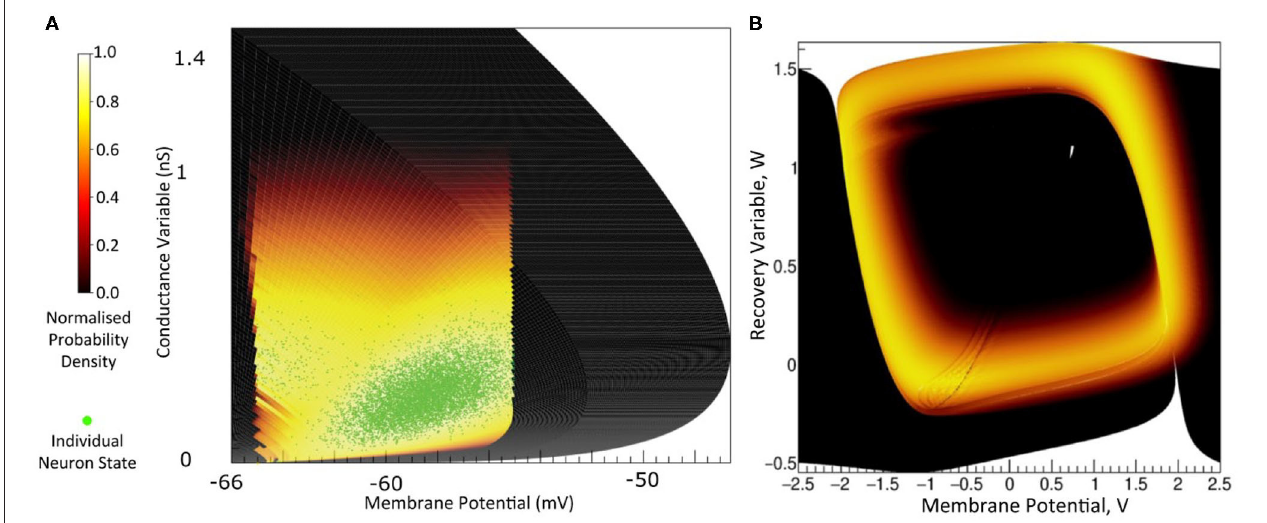
FIGURE 1 | (A) The state space of a conductance based point model neuron. It is spanned by two variables: the membrane potential and a variable representing how open the channel is. This channel has an equilibrium potential that is positive. The green dots represent the state of individual neurons in a population. They are the result of the direct simulation of a group of neurons. MIIND, however, produces the heat plot representing a density (normalised to the maximum density value) which predicts where neurons in the population are likely to be: most likely in the white areas, least likely in the red areas and not at all in the black areas. The sharp vertical cut of the coloured area at − 55 mV represents the threshold at which neurons are removed from state space. They are subsequently inserted at the reset potential, at their original conductance state value. (B) The state space of a Fitzhugh-Nagumo neuron model. The axes have arbitrary units for variables V and W . There is no threshold-reset mechanism and the density follows a limit cycle. After a certain amount of simulation time, neurons can be found at all points along the limit cycle as shown here by a consistently high